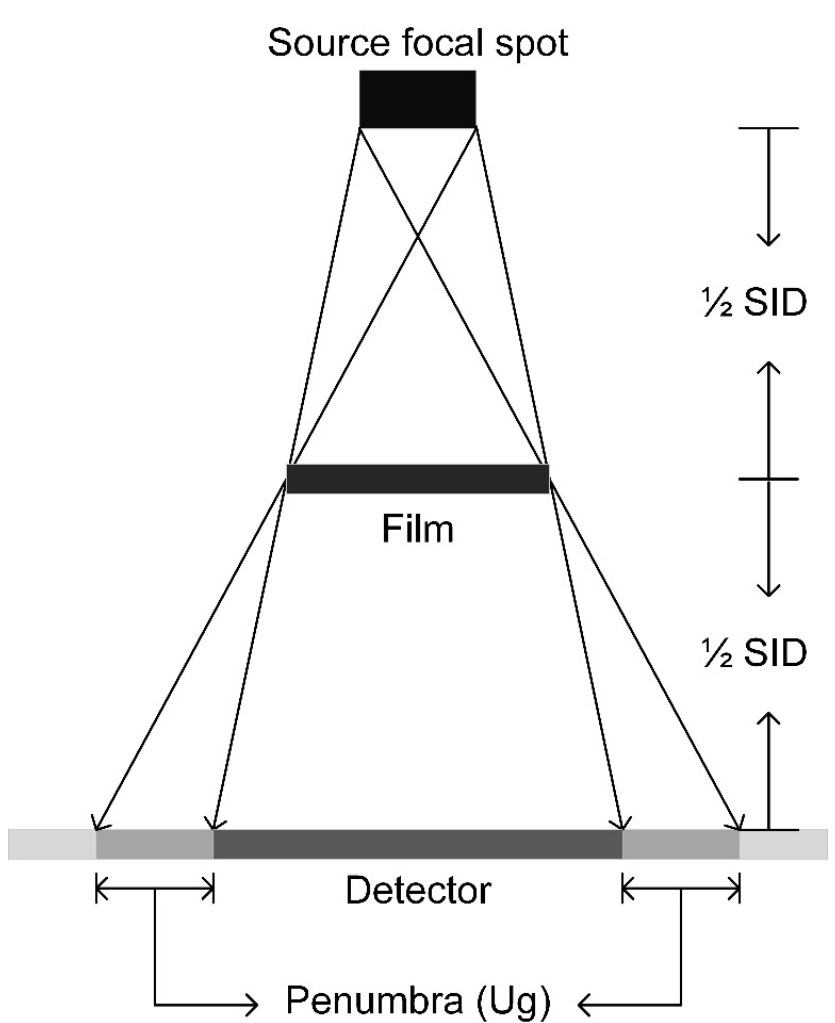
Figure 3. Illustration of film radiation attenuation measurement. A source-to-image distance (SID) was set at 45 cm and films were suspended with a stand at half of the SID.